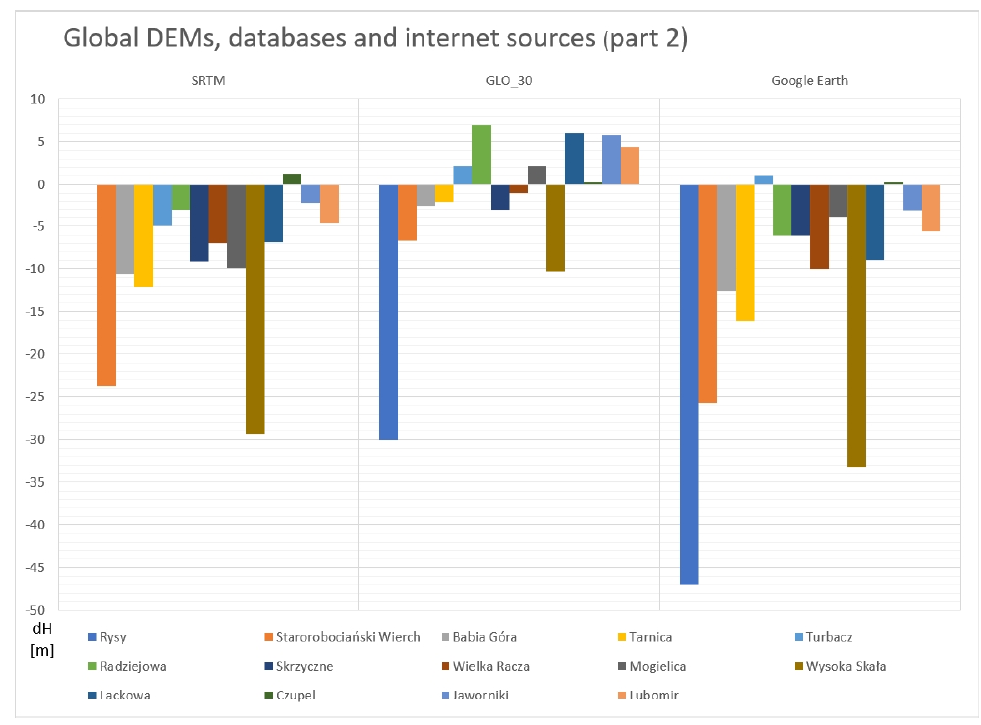
Figure A3. Height difference with GNSS surveying for Global DEMs, databases, and Internet sources (part 2). Source: authors.